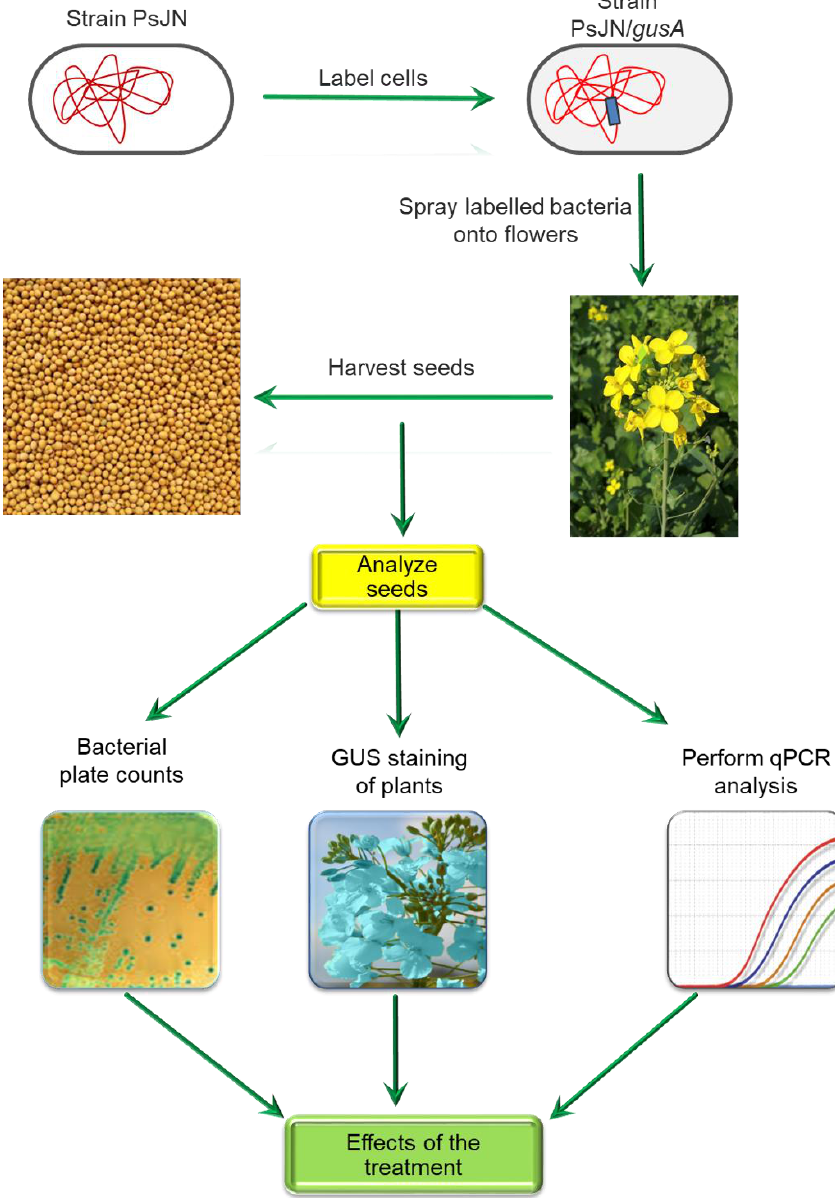
Figure 3. Schematic overview of a procedure used to introduce specific endophytic bacteria into plant seeds to become a component of the plant root microbiome. The gusA gene encodes the enzyme β